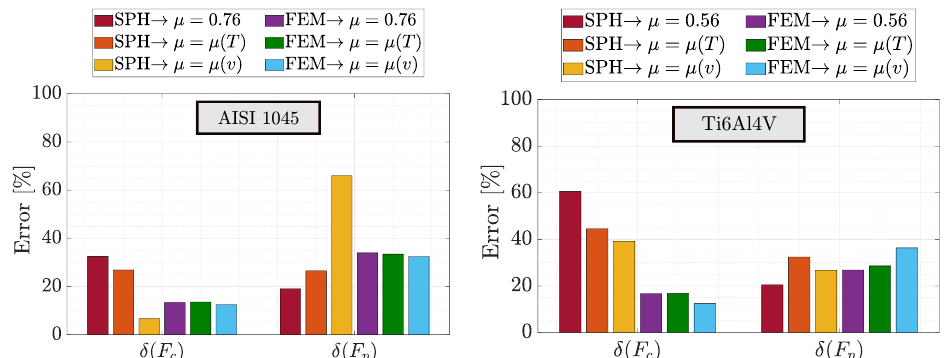
Figure 5. Overall percent error of force prediction in SPH and FEM using different friction coefficients. FEM results of AISI 1045 are computed with the modified JC model, given in Equation (7). Each error bar represents an average of 9 data points resulting from the variation of 3 cutting velocities and 3 uncut chip thicknesses for each material, as listed in Tables 2 and 3, where γ = 0 ◦ , α = 10 ◦ , and r β = 10 µ m in all